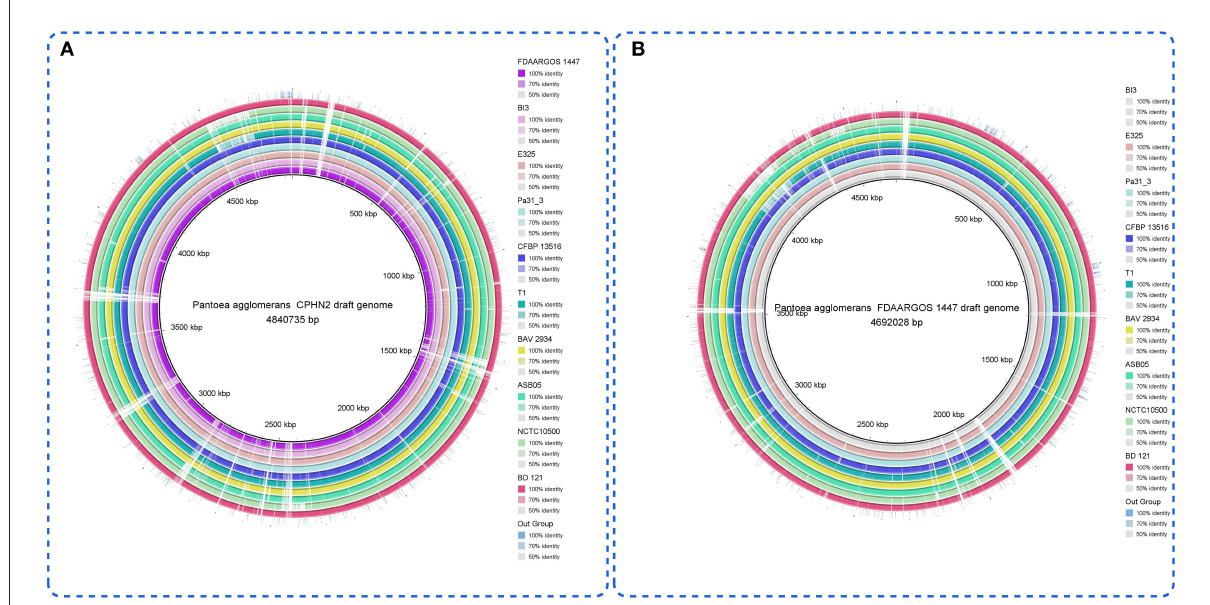
FIGURE3 (A) Genome comparisons of different P. agglomerans strains to the drafted CPHN2 genome created by BRIG 0.95. The inner cycle (back) reflects the whole genome of the reference strain CPHN2, and the shade of each color indicates the similarities between all strains with the strain CPHN2. (B) With genome comparisons of other P. agglomerans strains except for CPHN2 vs. the reference genome (FDAARGOS 1447), the circular map depicts the full-genome comparison of the strain FDAARGOS 1447 against the other 10 sequenced P. agglomerans and an out group.